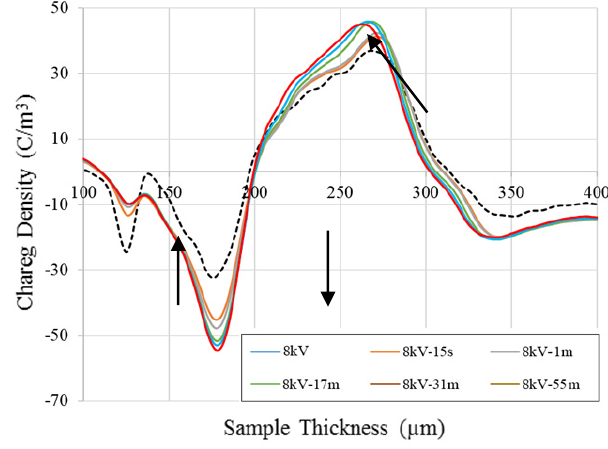
Figure 32. Space charge distribution in PPLP film under 8 kV applied voltage (volt ‐ on).